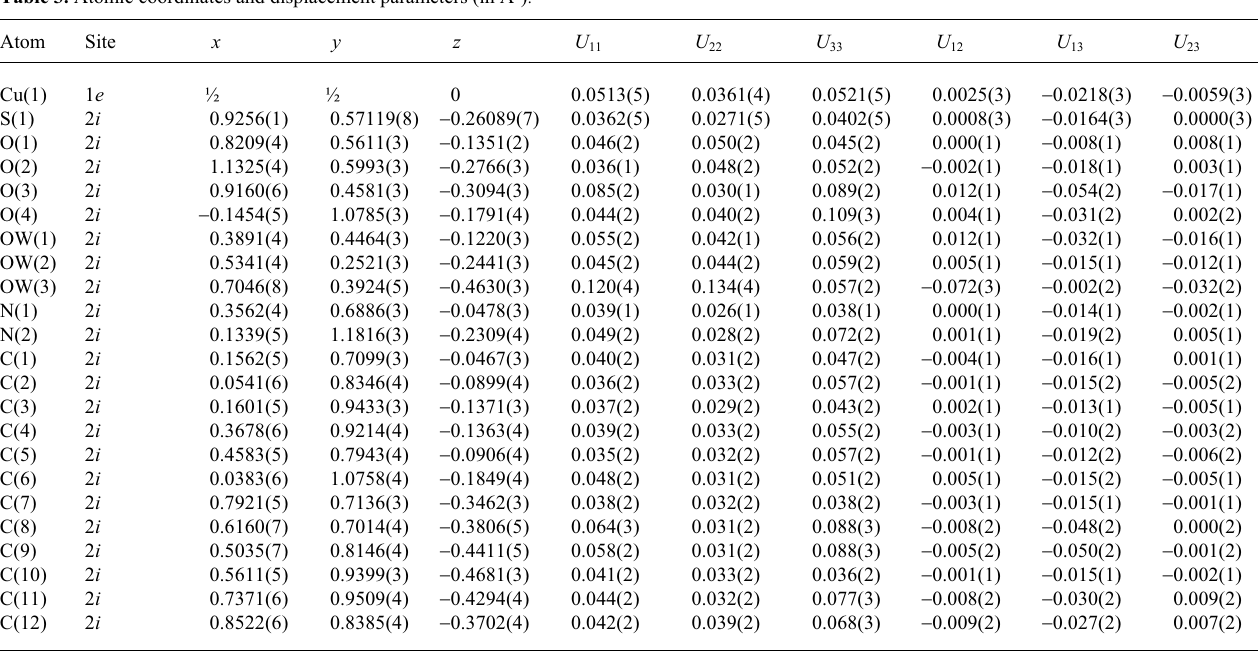
Table 3. Atomic coordinates and displacement parameters (in Å 2 ) .